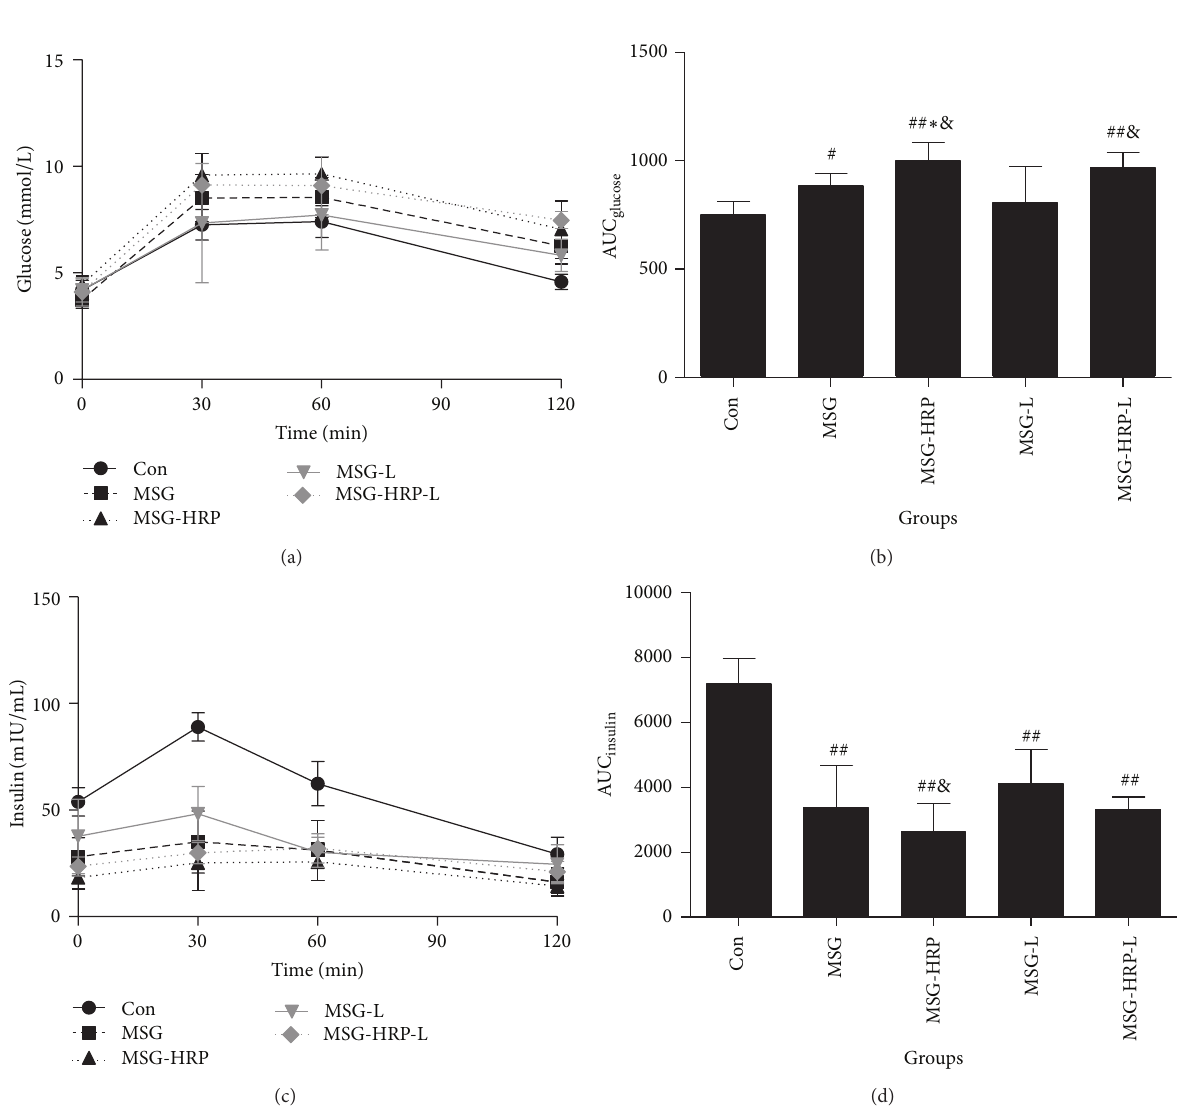
Figure 1: Samples for glucose (a) and serum insulin (c) before and 30 min, 60min, and 120min after glucose load were obtained and AUCs were calculated ((b) and (d), resp.). ∗ Compared with MSG group, 𝑃 < 0.05 ; ∗∗ compared with MSG group, 𝑃 < 0.01 ; # compared with Con group, 𝑃 < 0.05 ; ## compared with Con group, 𝑃 < 0.01 ; & compared with MSG-L group, 𝑃 < 0.05